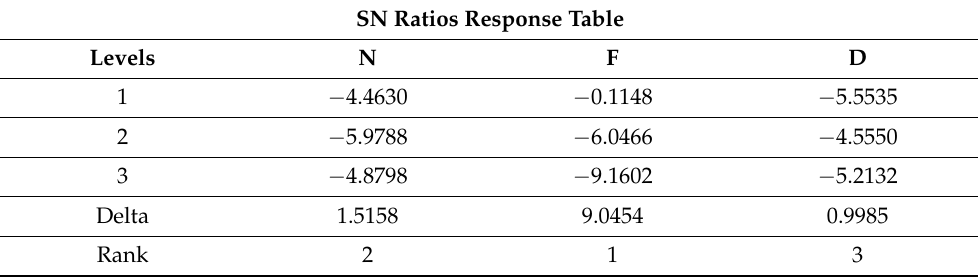
Table 5. Taguchi analysis details of SR vs. N, F, and D.